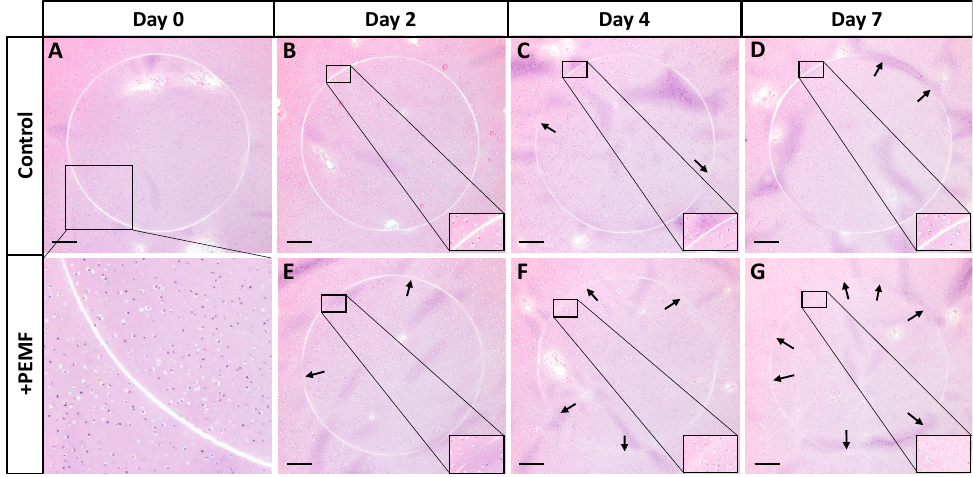
Figure 11. H&E ‐ stained bovine cartilage explants to assess defect repair for ( A – D ) control and ( E – G ) PEMF treated samples (Scale bar = 300 μ m). A uniform defect region was formed by removing 1 mm subcores and reinserting the annuli into the cartilage explant. Arrows indicate areas of closure along the cell ‐ free defect region.